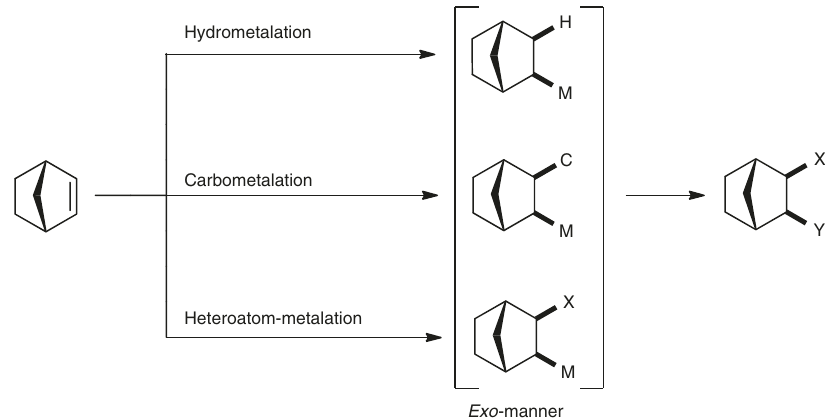
Fig. 1 Conventional key steps in catalytic addition reactions to norbornene. Irrespective of the mechanism, the addition reactions of X – Y species to norbornene proceed in an exo -manner